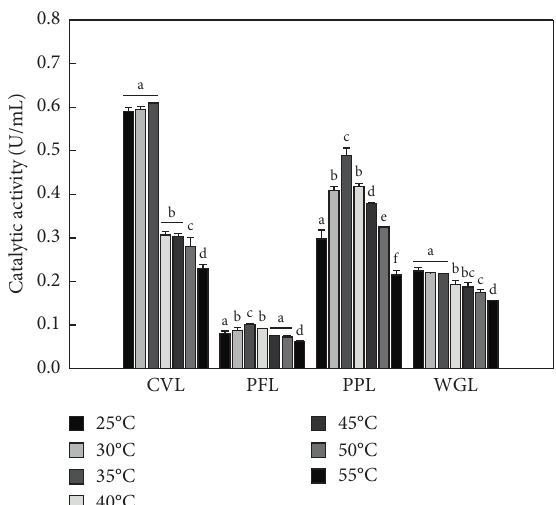
Figure 6: Effects of operating temperature on the catalytic activity of lipases against 4-methylumbelliferyl oleate as a substrate. The operating temperature was in the range of 25–55 ° C. Error bars indicate the standard error of the mean. Superscripts (a–f) above the bars denote significant differences in catalytic activity ( p < 0 . 05, Duncan’s multiple range test on ANOVA). CVL, Chromobacterium viscosum lipase (0.1 μ g/mL); PFL, Pseudomonas fluorescens lipase (0.1 μ g/mL); PPL, porcine ( Sus scrofa ) pancreatic lipase (10mg/mL); WGL, wheat germ ( Triticum aestivum ) lipase (1